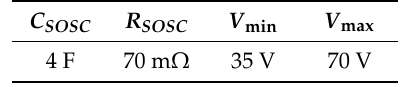
Table 1. Stack of Super-Capacitors (SOSC) parameters and voltage range.